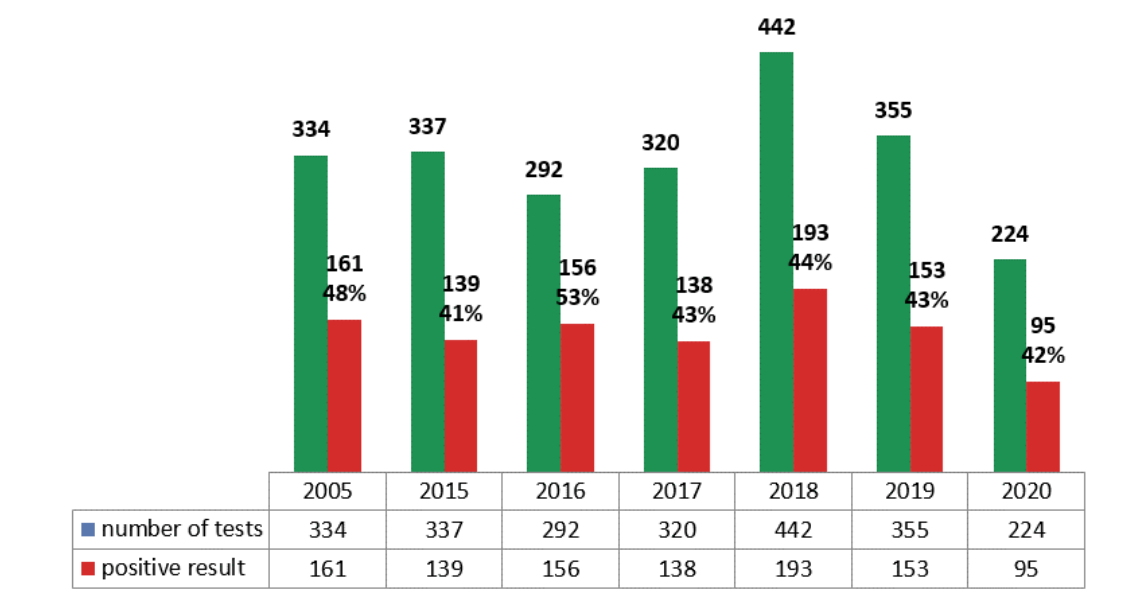
Figure 1. Mycological tests performed in DOH in the studied years, including positive results.